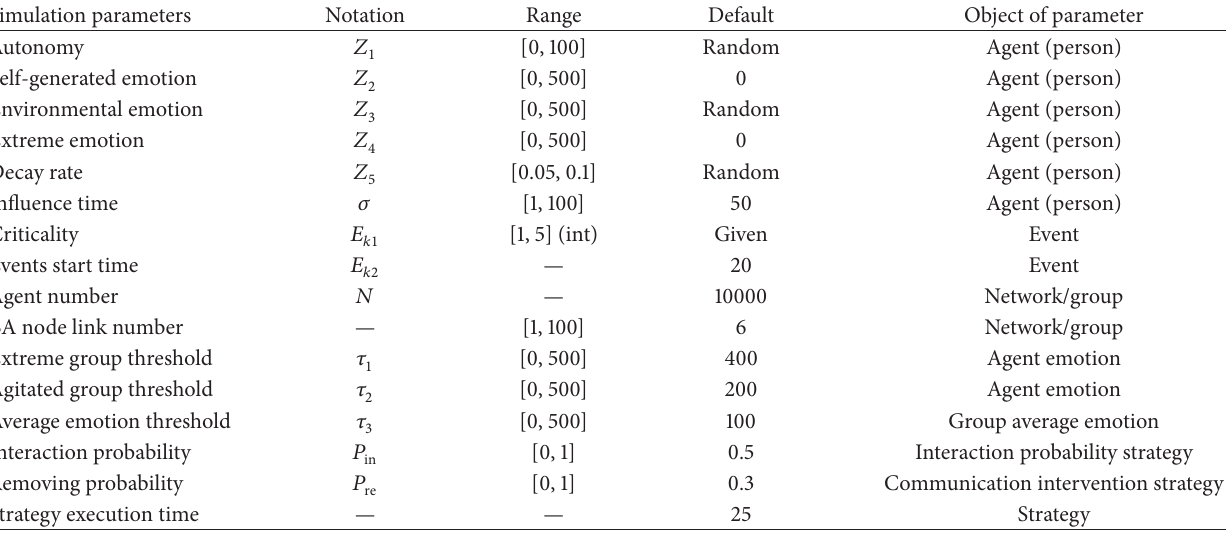
Table 1: The initial parameters settings found.